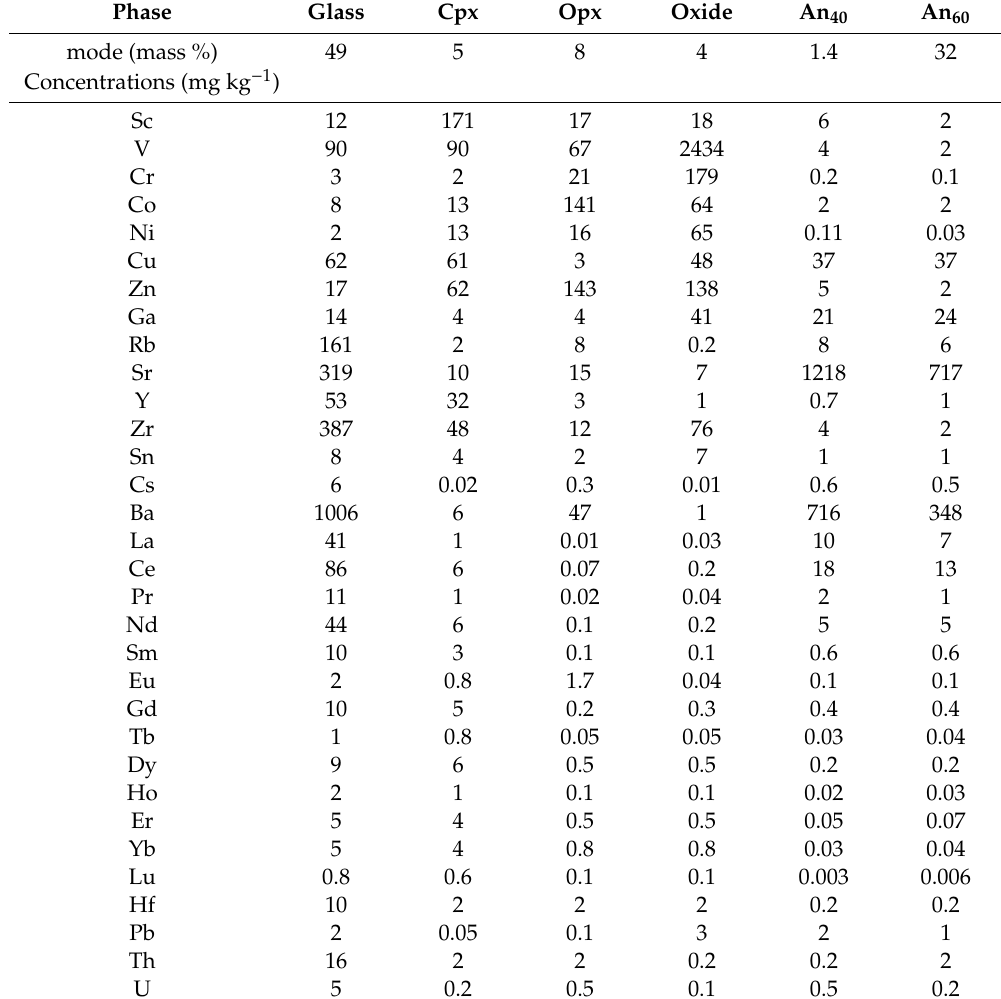
Table 3. Estimated modes and trace element concentrations for phenocrysts and glass in the andesite starting material. Abbreviations as in Table 1, An 40 and An 60 are plagioclase at 40 and 60 mole % anorthite component